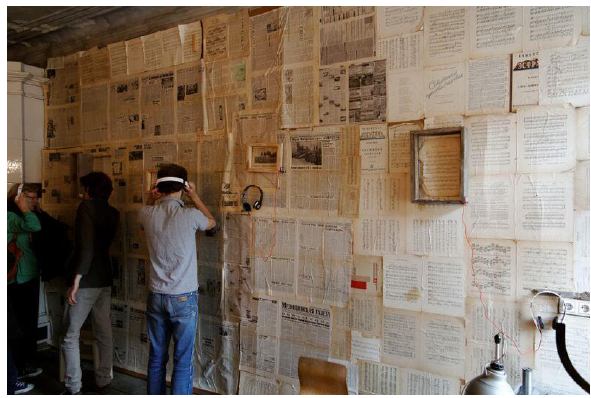
Figure 9 | Laboratory of Poetry Actionism. Part of the “Apartment Art as Domestic Resistance” exhibition series curated by Roman Osminkin and Olesya Turkina for MANIFESTA 10 Public